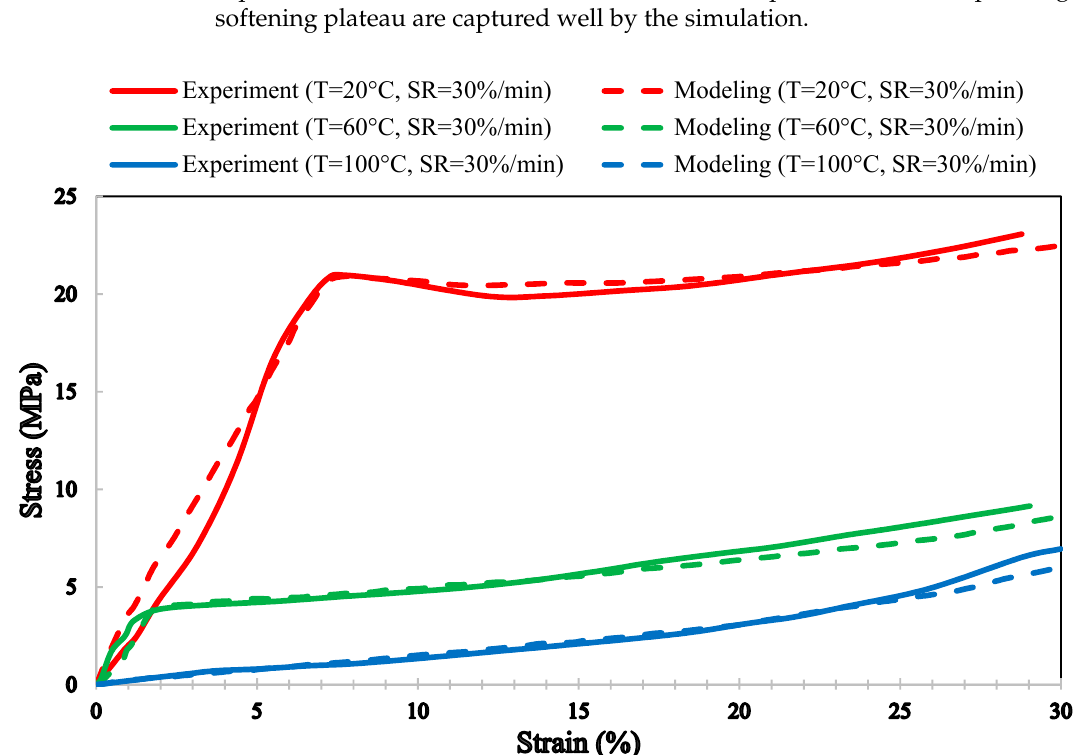
Figure 6. Comparison of experimental and computational stress-strain curves of Styrene SMP foams at different temperatures with a strain rate of 30%/min.